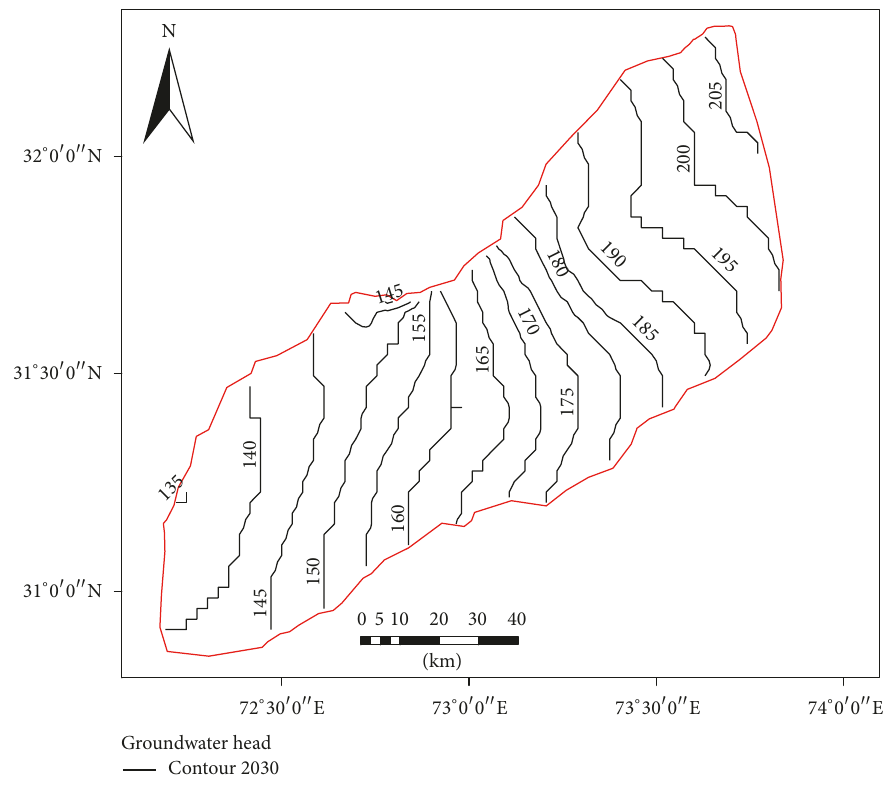
Figure 10: Predicted groundwater level in 2030 (Scenario I).